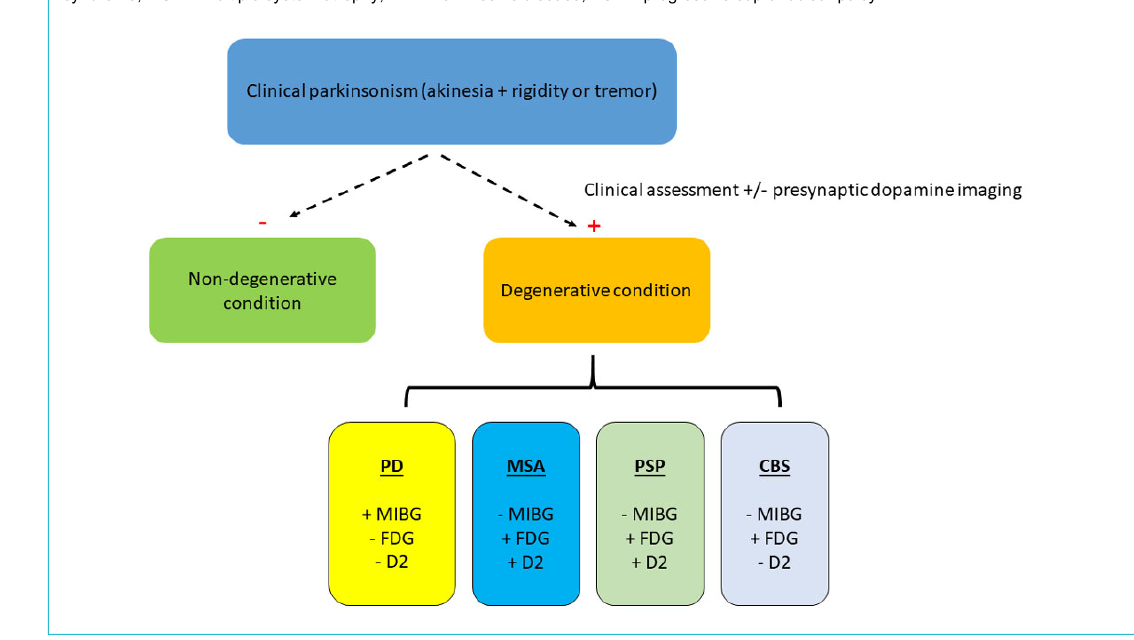
Figure 4: Proposed clinical work-up in the evaluation of a subject with parkinsonism; (-) is normal and (+) pathological.CBS = corticobasal syndrome; MSA = multiple system atrophy; PD = Parkinson’s disease; PSP = progressive supranuclear